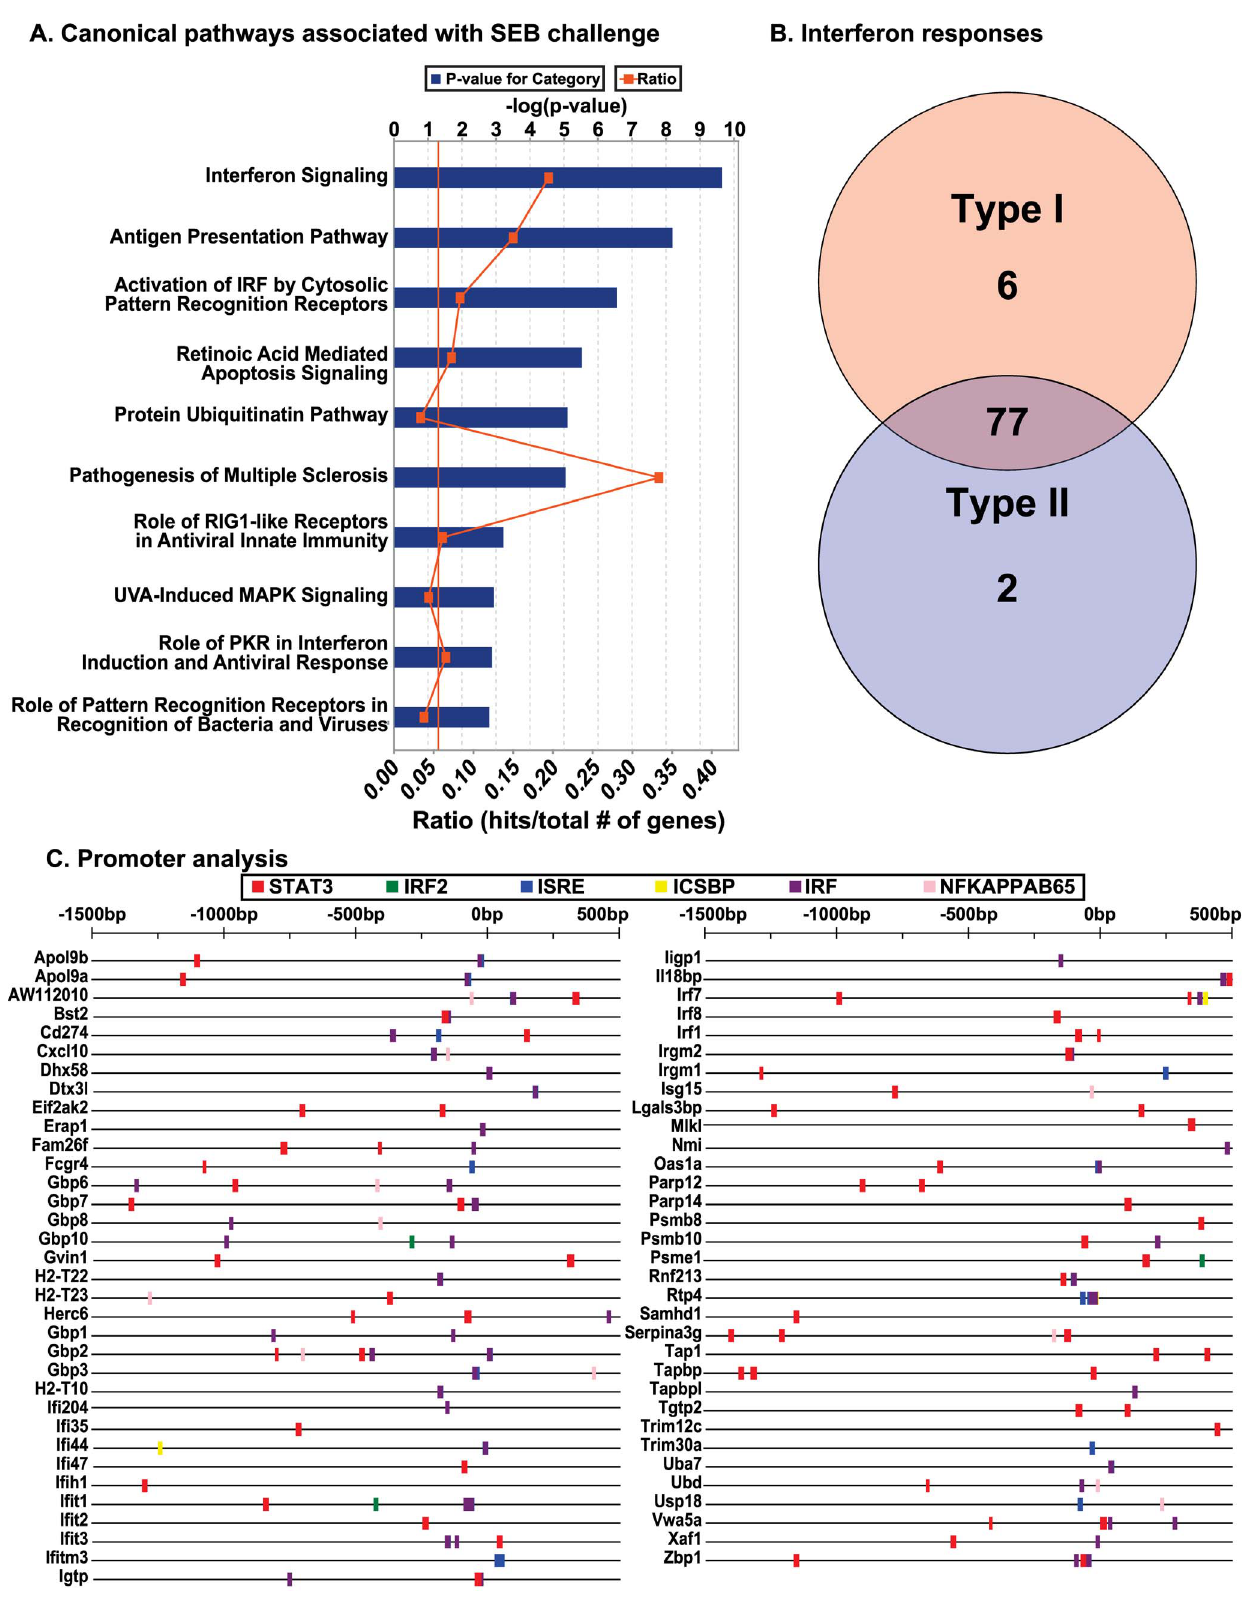
Figure 5. Thematic analysis, interferon (IFN) response subtype classification, and promoter analysis for binding matrices responsive to IFN. (A) Canonical pathways significantly associated with the all-tissue response to staphylococcal enterotoxin B (SEB) challenge. Seventy-nine unique genes were recognized by the Ingenuity Pathway Analysis H (IPA H ) database and mapped to IFN signaling, antigen presentation,